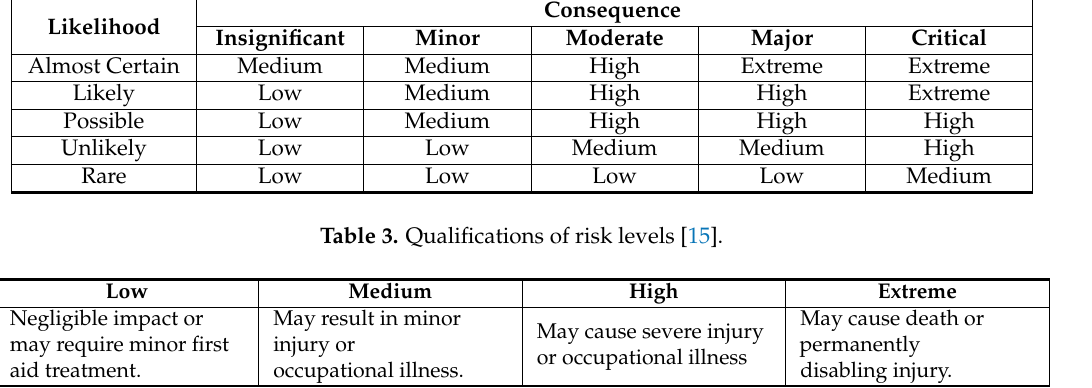
Table 2. Risk Level Identification [16].